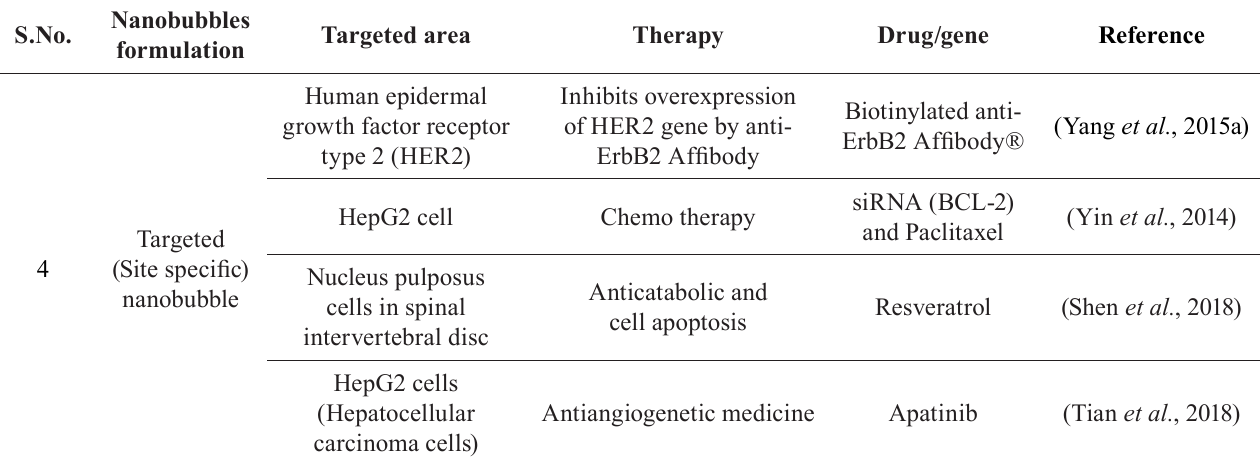
TABLE I - R ecent advances in nanobubbles formulation in the treatment of specific targeted tissues with the application of US energy